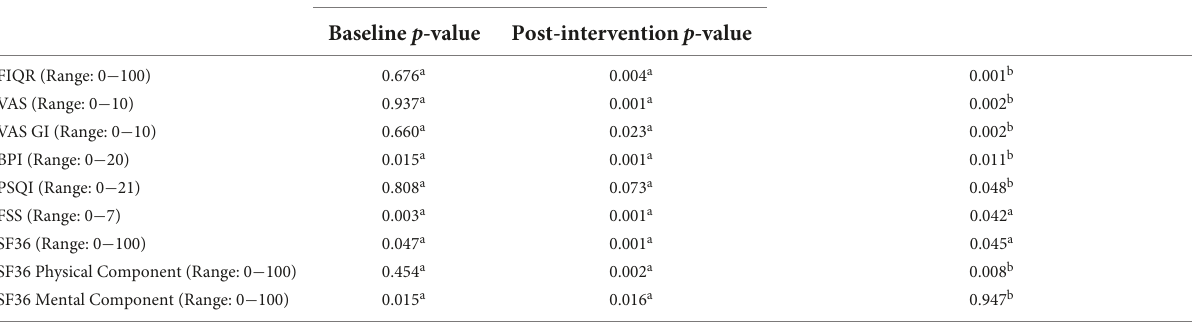
TABLE 5 Between-group analysis of clinical